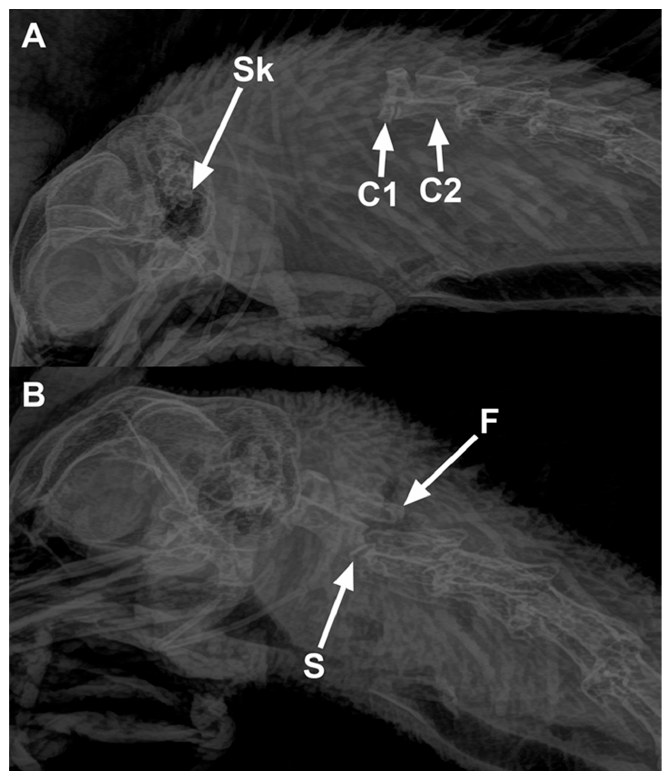
Figure 2. Radiographs of chickens showing cervical dislocations. ( A ) Luxation between the skull and C1 vertebra in a 65-week-old rooster killed by manual cervical dislocation: Sk—Skull, C1—first cervical vertebra, and C2—second cervical vertebra. ( B ) Subluxation between C2 and C3 (letter S shows the site of subluxation) in a 65-week-old rooster killed by KED: fractures (F) are present on the articular processes of the C3 vertebra.